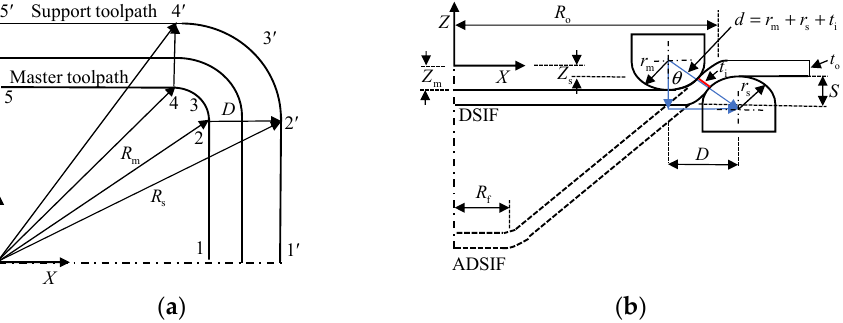
Figure 3. DSIF and ADSIF toolpath generation strategy (reprinted with permission from S. Ullah et al. [22]). ( a ) top view ( b ) side view.